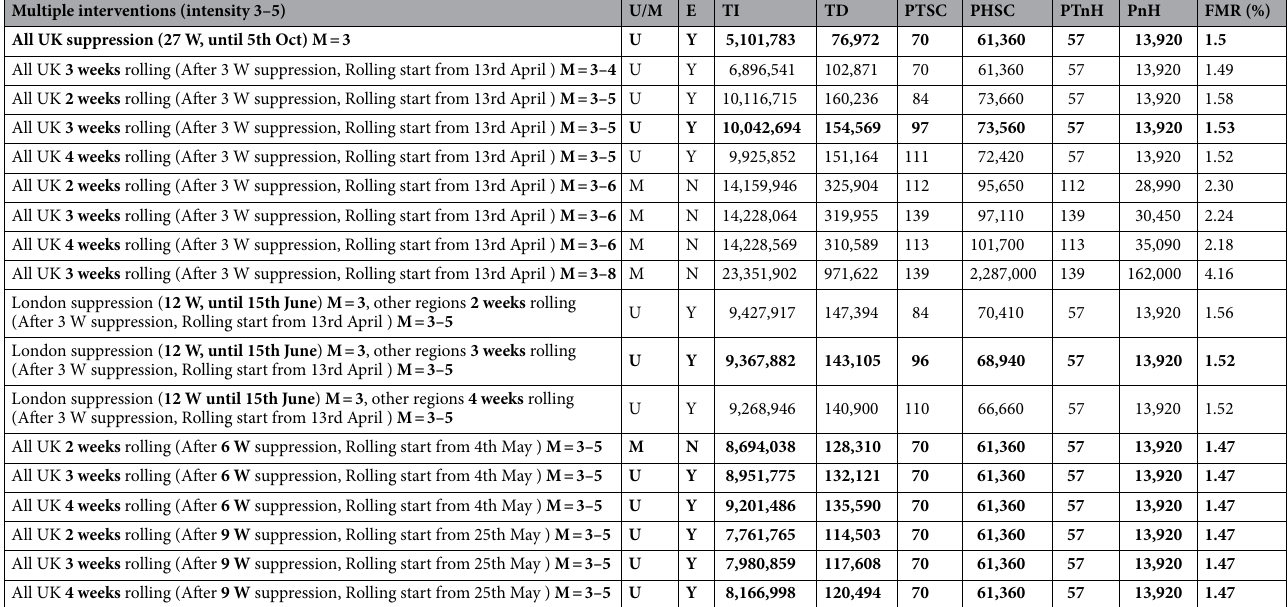
Table 1. Performance comparison of rolling interventions in the UK. FMR, Final morality rate = Total deaths/ Total infections; PHSC, peak value of healthcare demand (severe and critical cases); PTSC, peak time of healthcare demand; PnH, peak value of non-hospital population; PTnH, peak time of non-hospital population; TD, total deaths (UK); TI, total infections (UK); E, End in 1 year; D, distribution